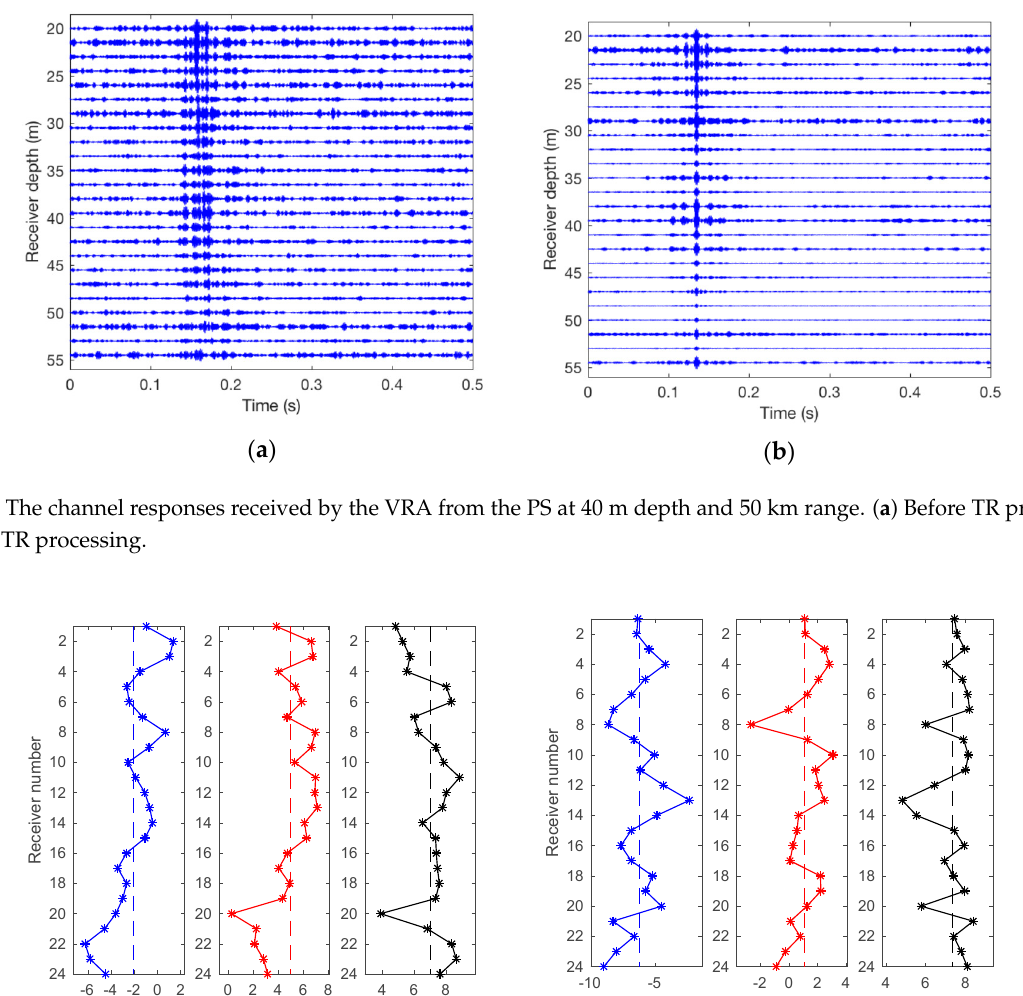
Figure 3. The channel responses received by the VRA from the PS at 40 m depth and 50 km range. ( a ) Before TR processing; ( b ) After TR processing.